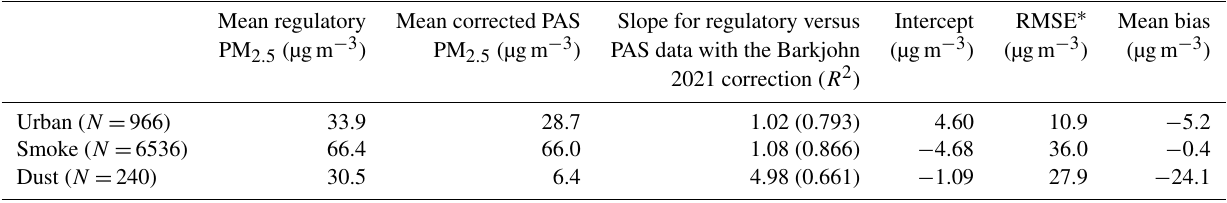
Table 3. Relationship between hourly regulatory PM 2 . 5 and corrected PAS PM 2 . 5 with the Barkjohn 2021 algorithm. Data are included for all simultaneous measurements for the 50 identified events in Part I. ( N gives the number of hours of data of each type.)